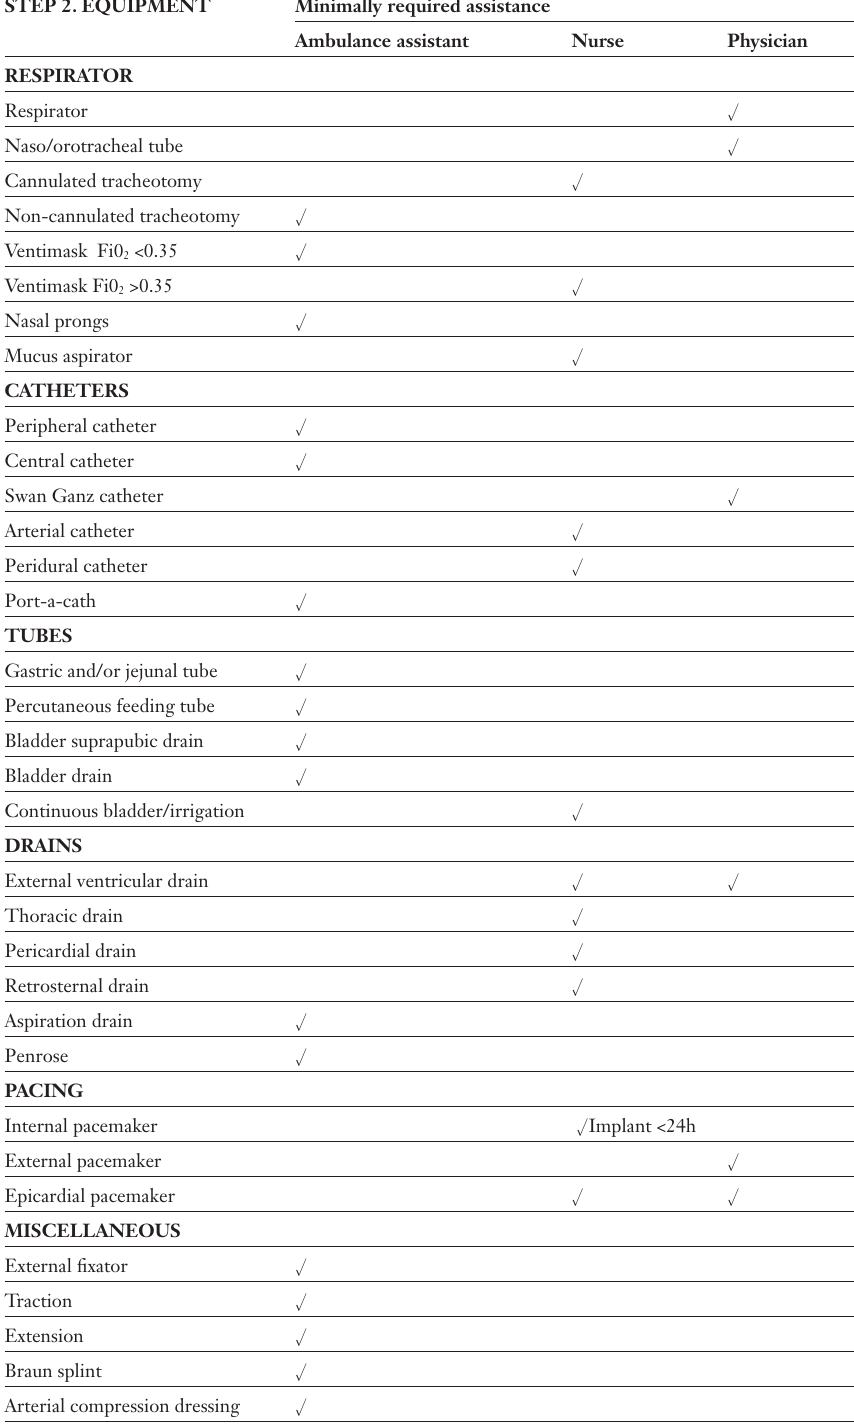
Algorithm for assessment of patient’s required assistance by type of